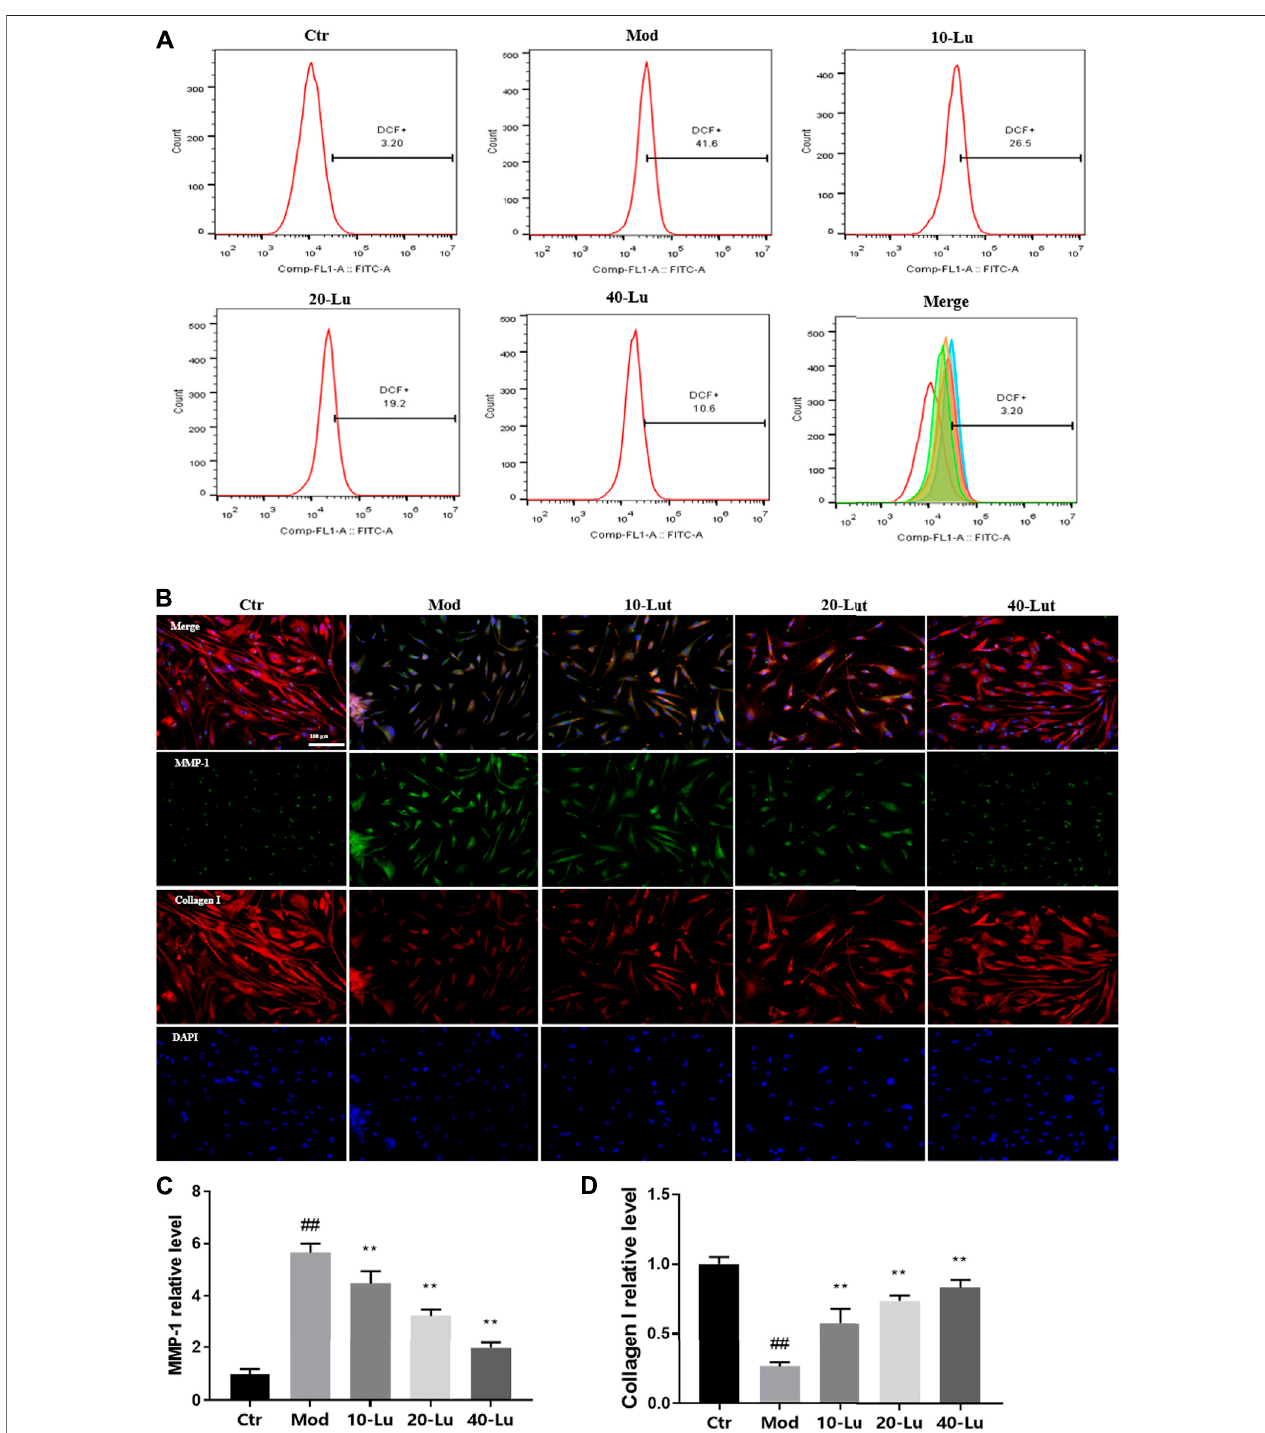
FIGURE 5 | Luteolin increases intracellular Collagen I expression and reduces ROS accumulation. (A) luteolin reduced intracellular ROS accumulation. (B) Representative image of immuno fl uorescence staining for MMP-1 and Collagen I. (C) luteolin reduced intracellular levels of MMP-1. (D) luteolin increased intracellular levelsofCollagenI.#indicatessigni fi cantdifferencebetweenthemodelgroupandtheblankgroup(# p < 0.05;## p < 0.01);*indicatessigni fi cantdifferencebetweenthe administered group and the model group (* p < 0.05; ** p < 0.01).